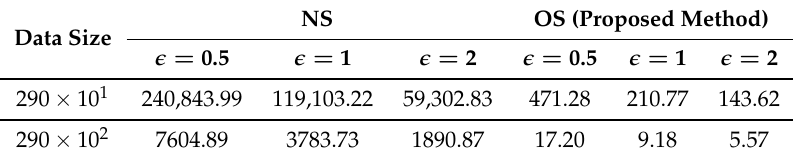
Table 1. Comparison of average error rates for varying privacy budget (cid:101) and data sizes. Data Size